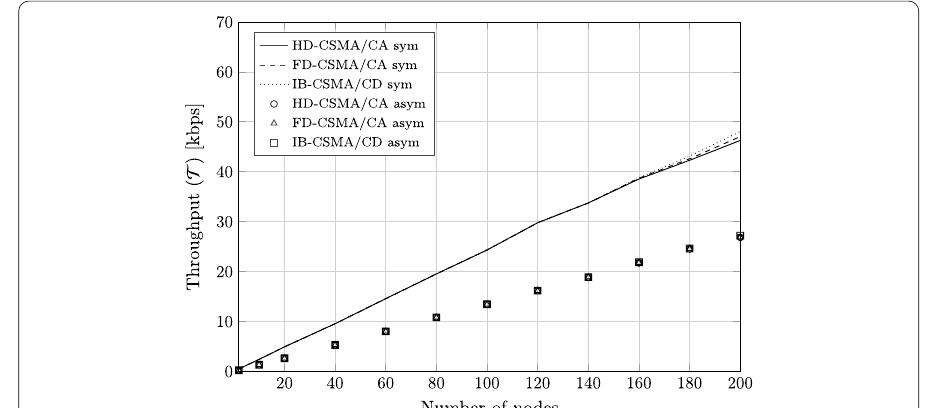
Fig. 10 Unsaturated scenarios (3 and 4): The throughput in unsaturated traffic conditions increases linearly in all schemes. There is no difference in throughput between the different